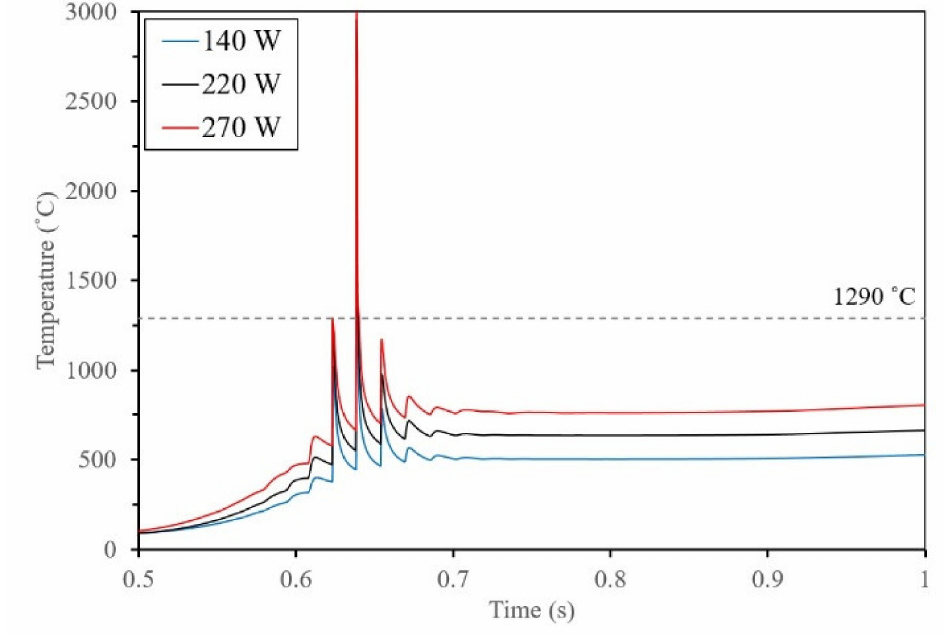
Figure 26. Temperature history for different laser powers at 650 mm/s and 0.12